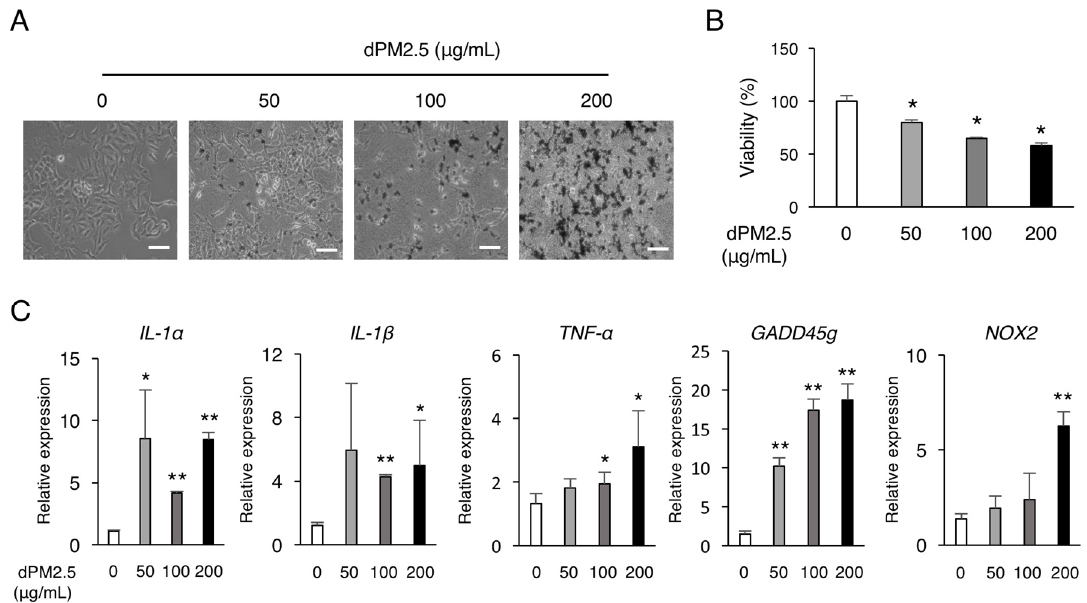
Figure 1. Diesel fine particulate matter (dPM2.5) decreased viability and induced inflammation. ( A ) Representative images of A549 cells cultured in various concentrations of dPM2.5 for 48 h. Bars, 100 µ m. ( B ) Viability of the cultured human A549 cells exposed to 0–200 µ g / mL dPM2.5 was determined by neutral red assay. The neutral red assay revealed that incubation with dPM2.5 decreased the viability in a concentration-dependent manner. ( C ) qPCR analysis for cell stress-related genes. Bars indicate the mean ± SD. * p < 0.05, ** p < 0.01.